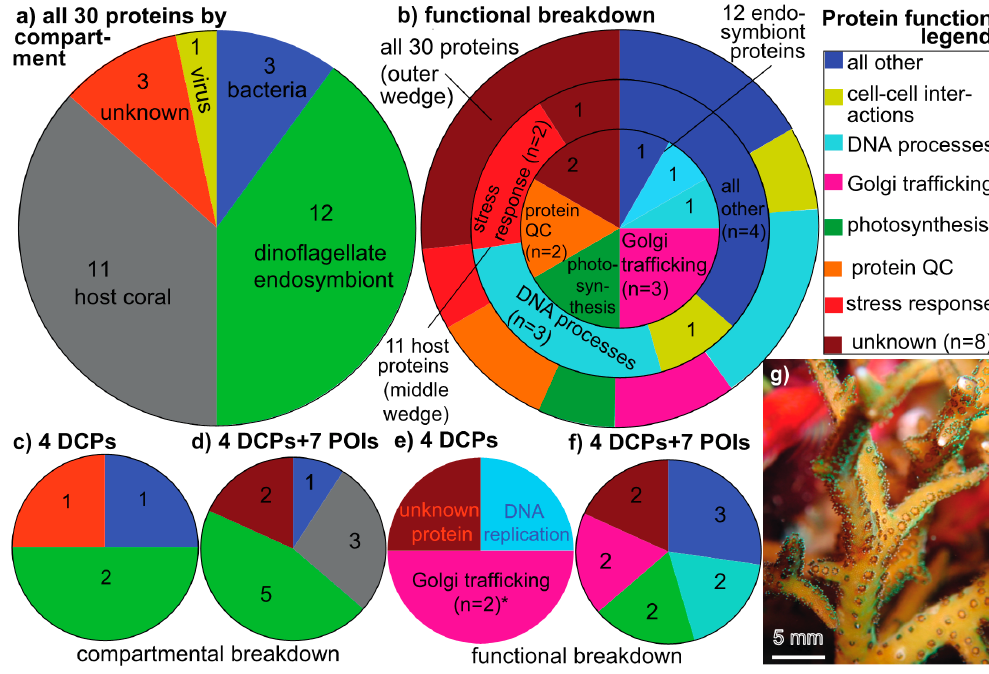
Figure 1. Compartmental and functional breakdown of the sequenced proteins, including those that were most di ff erentially concentrated across experimental treatments (DCPs). Compartmental breakdown ( a ) of the 30 proteins that passed all quality control criteria: host (grey), Symbiodiniaceae dinoflagellates (green), bacterial (blue), viral (yellow), and unknown (red). These colors are used in remaining panels depicting compartmental di ff erences ( c–d ), as well as in all following figures. Colors of the wedges in the DCP panels ( b , e , f ) instead correspond to the functional categories found in the “Protein function legend.” The lone functional category that was over-represented (Fisher’s exact test, p < 0.01) in the most di ff erentially concentrated proteome ( e ) versus the composite proteome ( b ) has been denoted by an asterisk (*). A macro image of a Seriatopora hystrix colony ( g ) from Komodo National Park (Indonesia). POI = protein of interest (see main text for